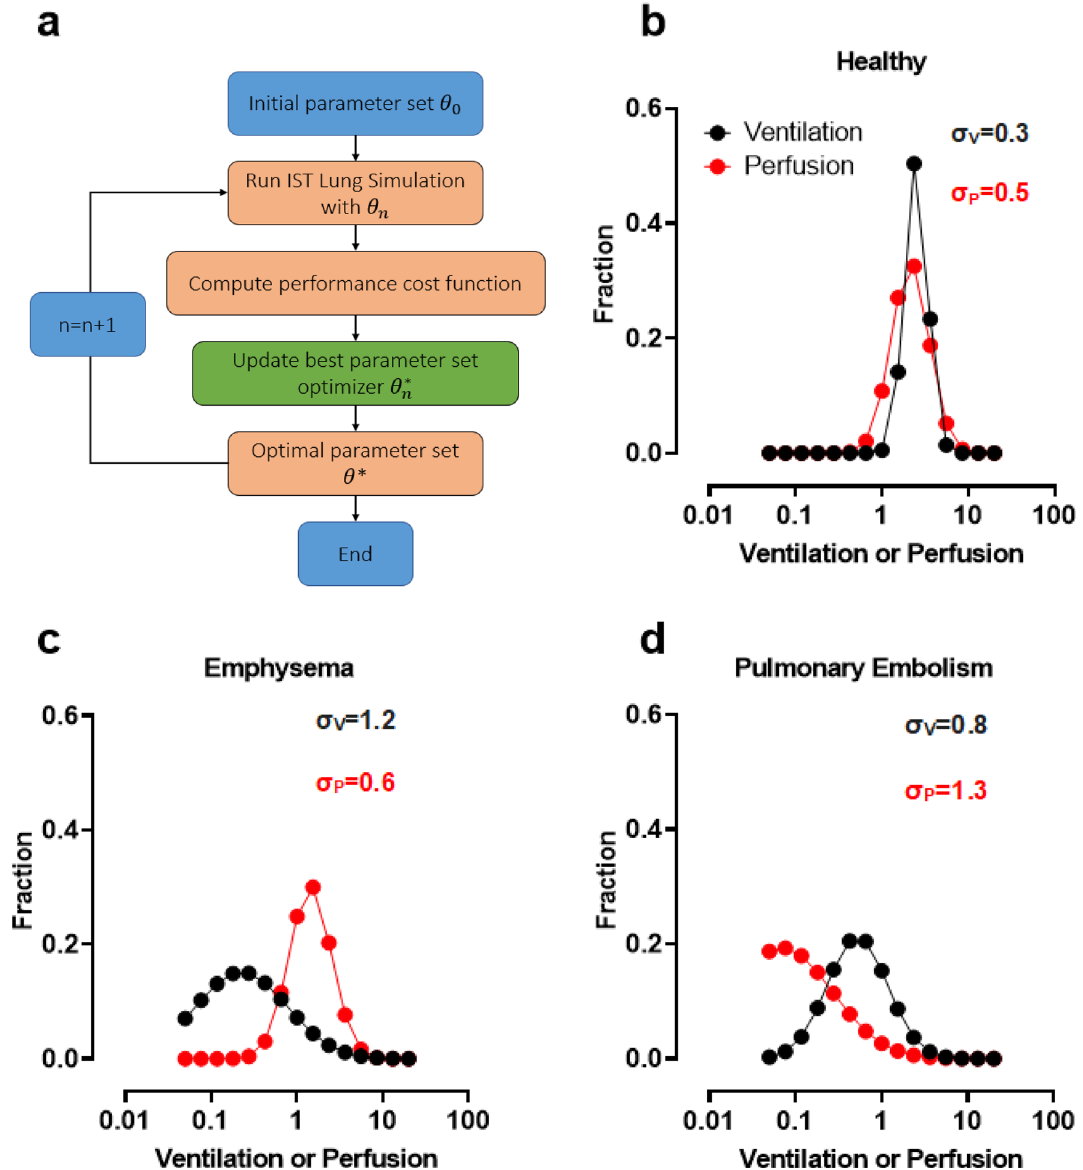
Figure 1. A schematic diagram of the lung simulation-based optimisation and examples of the simulated lognormal distributions. The model incorporated ventilatory and perfusion distributions which were taken from the literature, to represent the healthy individual and patients with emphysema and pulmonary embolism 33 . Panels b , c and d show the recovery of these distributions when a simulated IST is applied to the Fig. 3a, two distinct sub-populations of COPD phenotype can be observed in the distribution graph of σ V , indi- cating the wide range of disease severities within the diagnostic label of COPD. Furthermore, in healthy subjects, Fig. 3c shows the relationship between IST heterogeneity indices and age, R 2 = 0.42, p < 0.0001 which was found to be a linear (cid:31) = 0.0045 ∗ age + 0.75